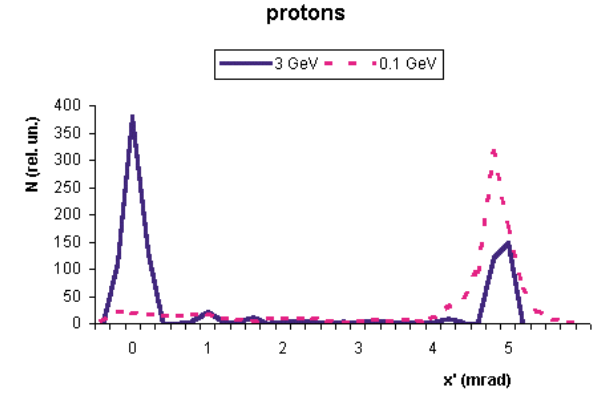
FIG. 3. (Color) The angular distribution of protons down- stream of the bent nanotube, shown for two